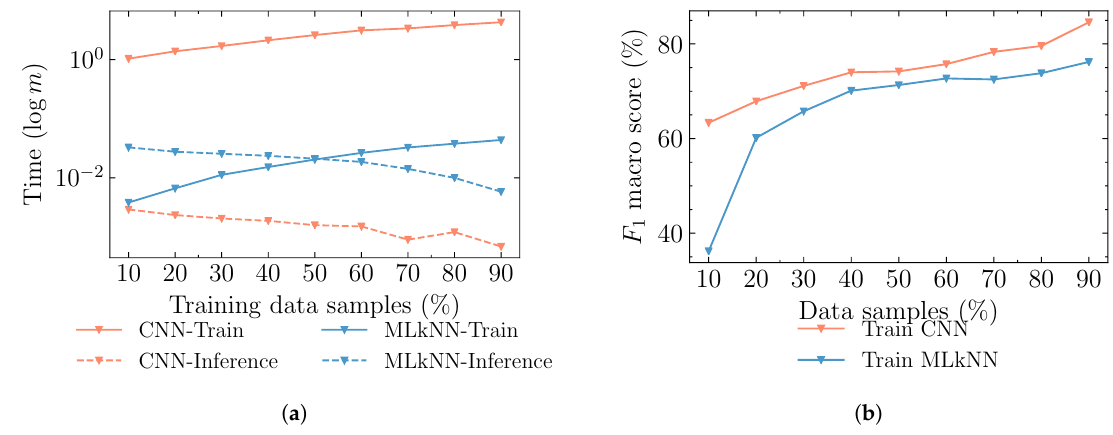
Figure 12. ( a ) Distributions of type errors the model makes. ( b ) Number of correct predictions for single, double and triple